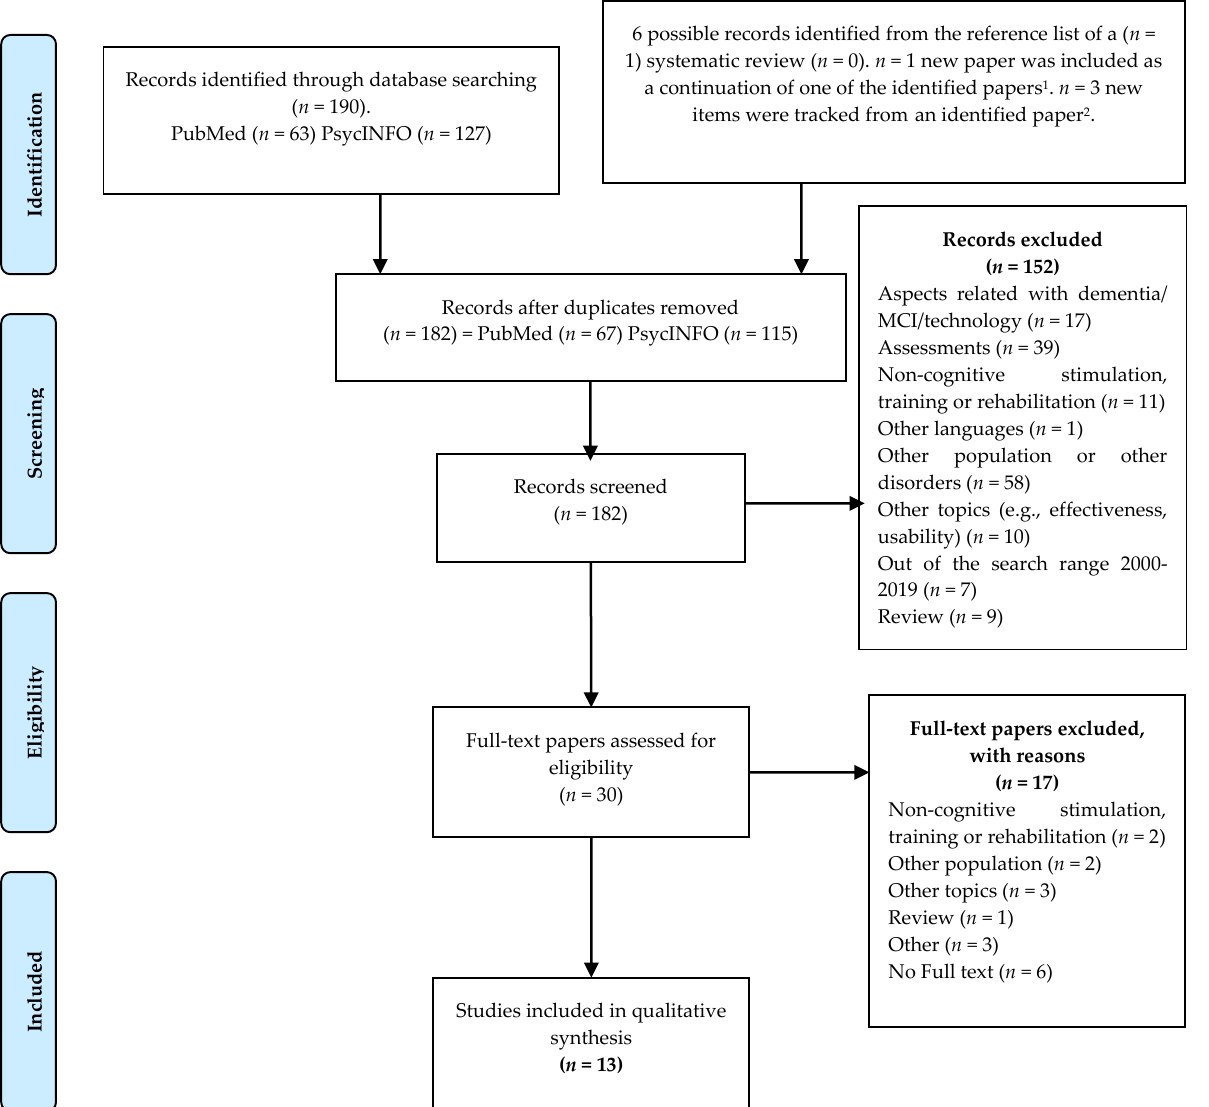
Figure 1. PRISMA Flow Chart. Selection process of the systematic review (From: Moher, Liberati [31]). 1 Haesner, O’Sullivan [35]. 2 Ben-Sadoun, Manera [39].